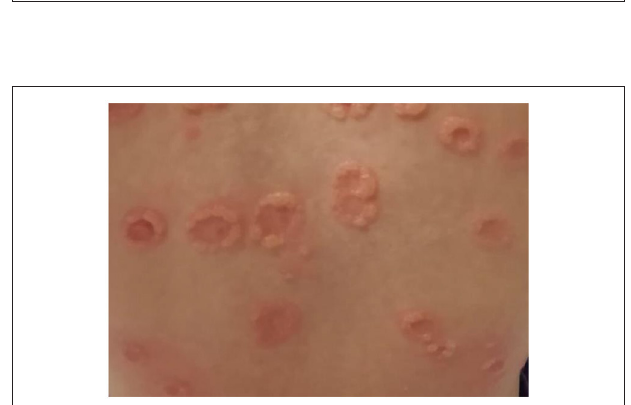
FIGURE 2 | Magnification of typical LABD lesions on the same